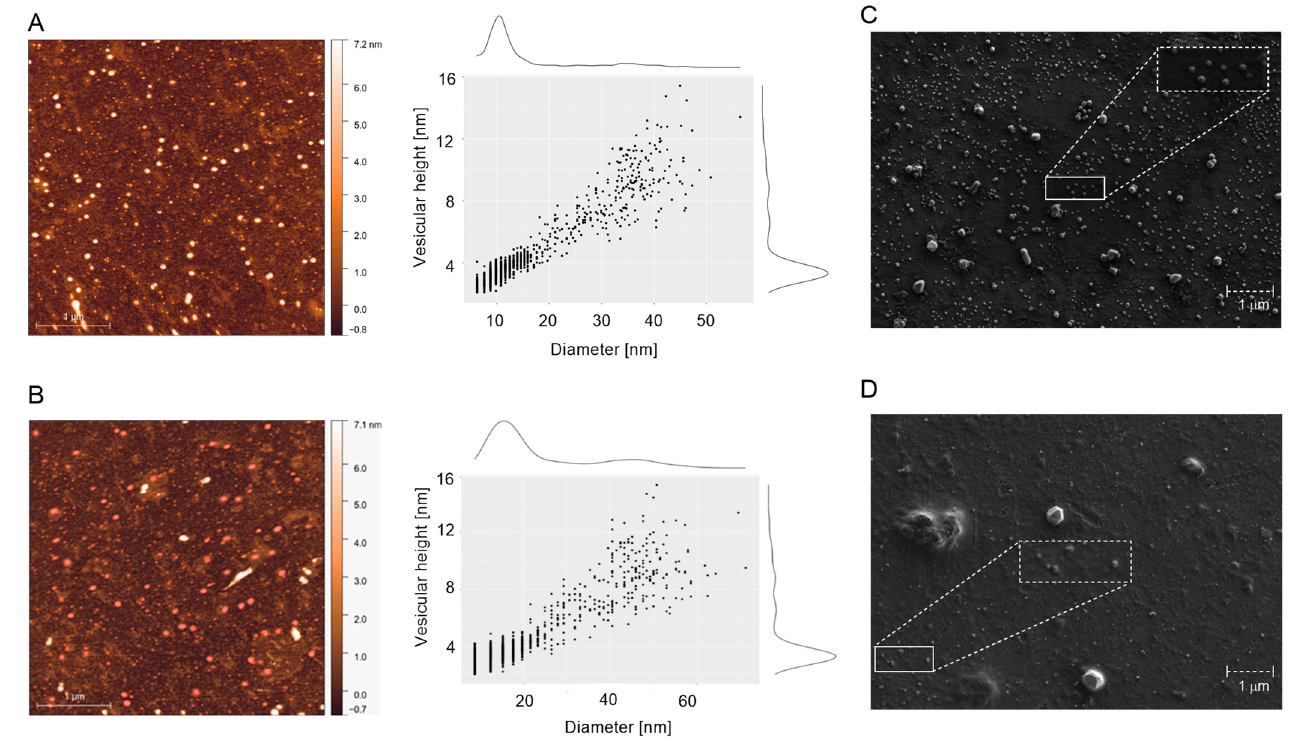
Figure 2. Atomic force microscopy (AFM) and field emission scanning electron microscope (FESEM) micrographs of grapefruit exosome vesicles (GEVs) and tomato exosome vesicles (TEVs). AFM topography scan (left) and cross section (right) of ( A ) GEVs and ( B ) TEVs. On the right of topography scans is the pseudo color ruler indicating the particles’ height (nm). FESEM micrographs of ( C ) GEVs and ( D ) TEVs. A representative group of vesicles has been magnified.